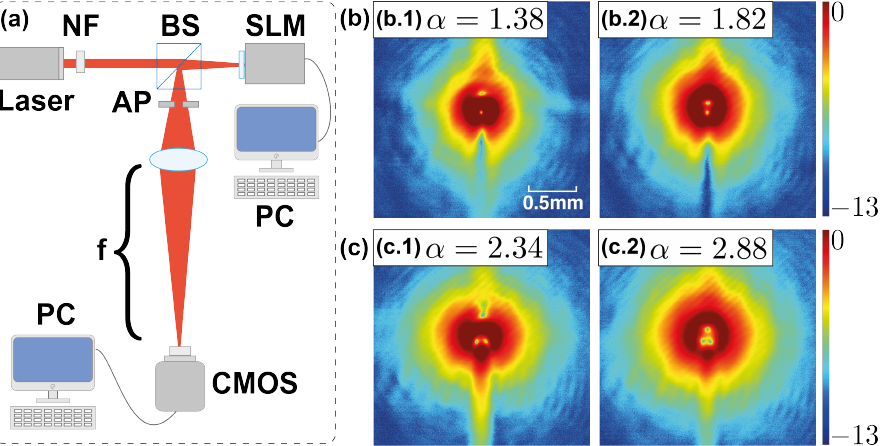
Figure 2. ( a ) Experimental setup: a collimated beam (HeNe, λ = 632.8 nm) hits the SLM programmed with one of the phase profiles. The focused field is imaged by means of the CMOS camera through a 2f system (f = 400 mm). Notation: NF, neutral filter; BS, beam splitter; AP, aperture. ( b , c ) Sample intensity profiles (logarithmic scale) for transition [ α ,1 → 2], ( b.1 ) α = 1.38, and ( b.2 ) α = 1.82. Transition [ α ,2 → 3], ( c.1 ) α = 2.34, and ( c.2 ) α =